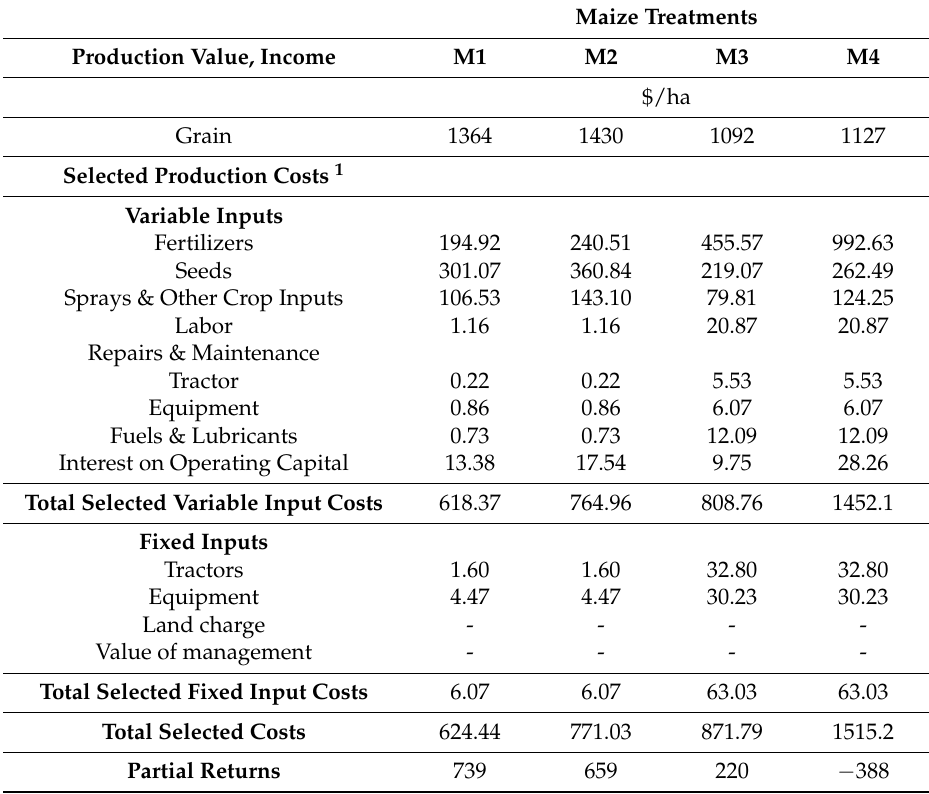
Table 6. Income, selected costs, and partial returns for conventional maize with recommended management (M1) and high input management (M2), and organic maize with recommended management (M3) and high input management (M4) at a Cornell Research Farm in central NY averaged across the 2015 and 2016 growing seasons 1